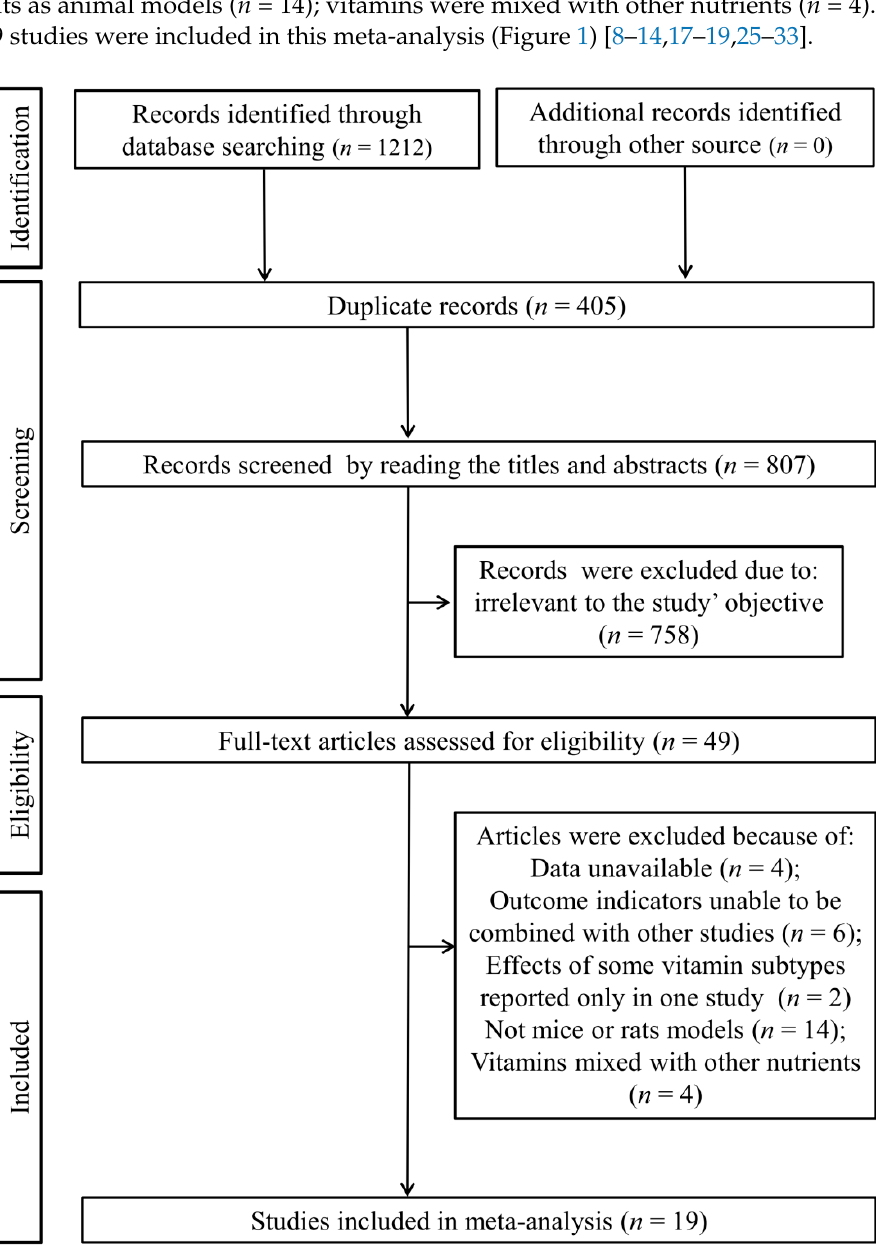
Figure 1. PRISMA